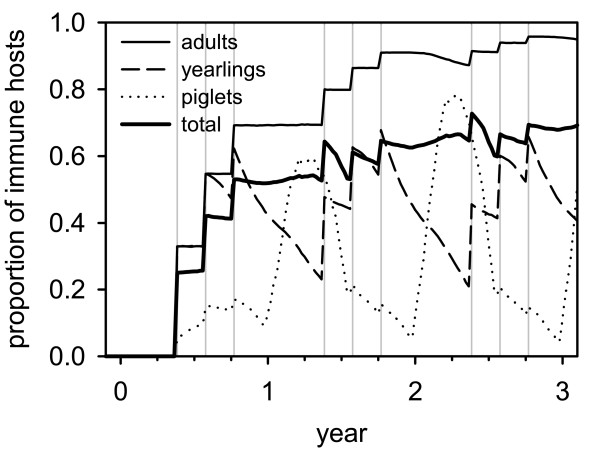
Time series of proportion of immune hosts due to oral mass vaccination (total and for age classes). Vertical grey lines denote dates of baiting campaigns.